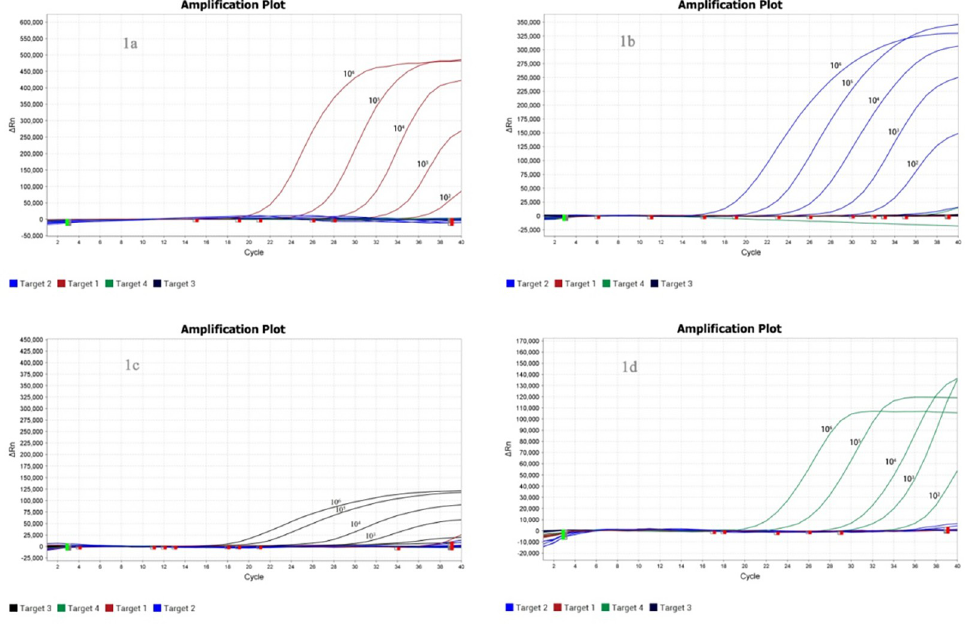
Fig 1. Sensitivity test results of the quadruple real-time RT-PCR diagnostic method for aMPV. (a) Sensitivity test results of the quadruple real-time RT-PCR diagnostic method for aMPV-A. (b) Sensitivity test results of the quadruple real-time RT-PCR diagnostic method for aMPV-B. (c) Sensitivity test results of the quadruple real-time RT-PCR diagnostic method for aMPV-C. (d) Sensitivity test results of the quadruple real-time RT-PCR diagnostic method for